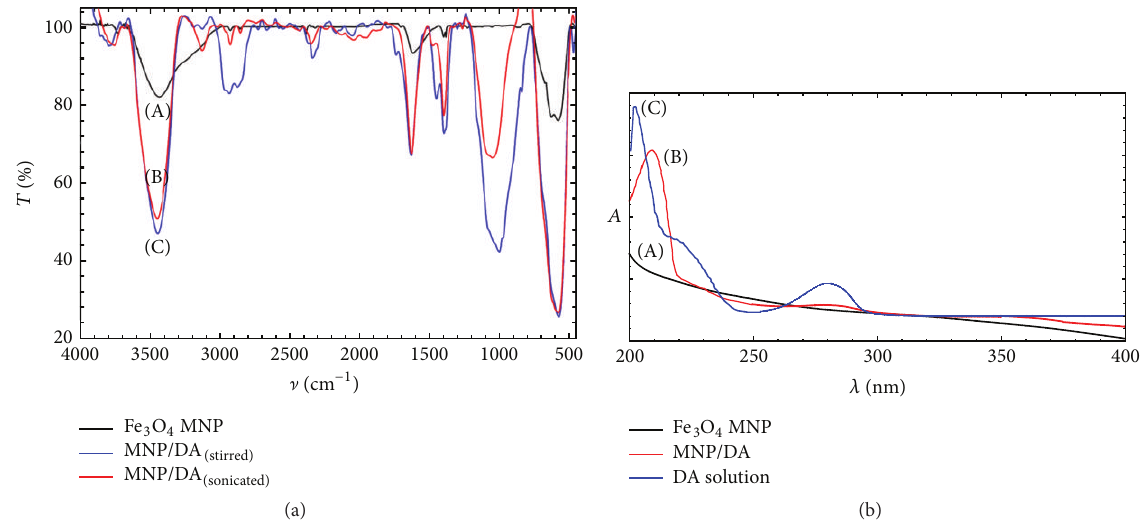
Figure 6: (a) Typical FTIR spectrum of the MNPs (A), MNP / DA ( for 30min in 200 mL PBS, pH = 7.0 , containing 1.0 × 10 −3 M DA. MNP / DA ( pH = 7.0 , containing 1.0 × 10 −3 M of DA. (b) UV-Vis spectrums of Fe 3 O 4 MNPs (A), Fe 3 O 4 /DA (B) and DA molecule